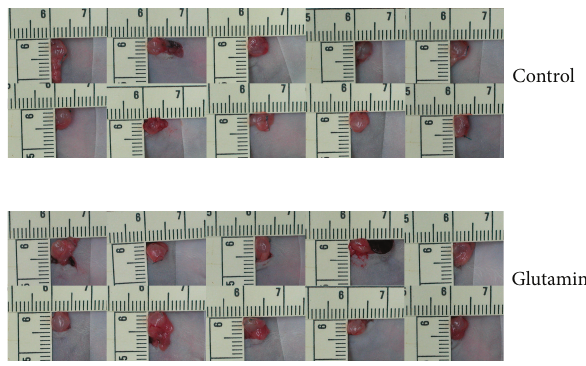
Figure 2: The remaining 5 mice in each group were observed until death for survival analysis. At day 85, only 1 animal in the control group was alive compared to all 5 mice in the GLN-treated group. Theabdominal circumference was obviously less intheGLN-treated